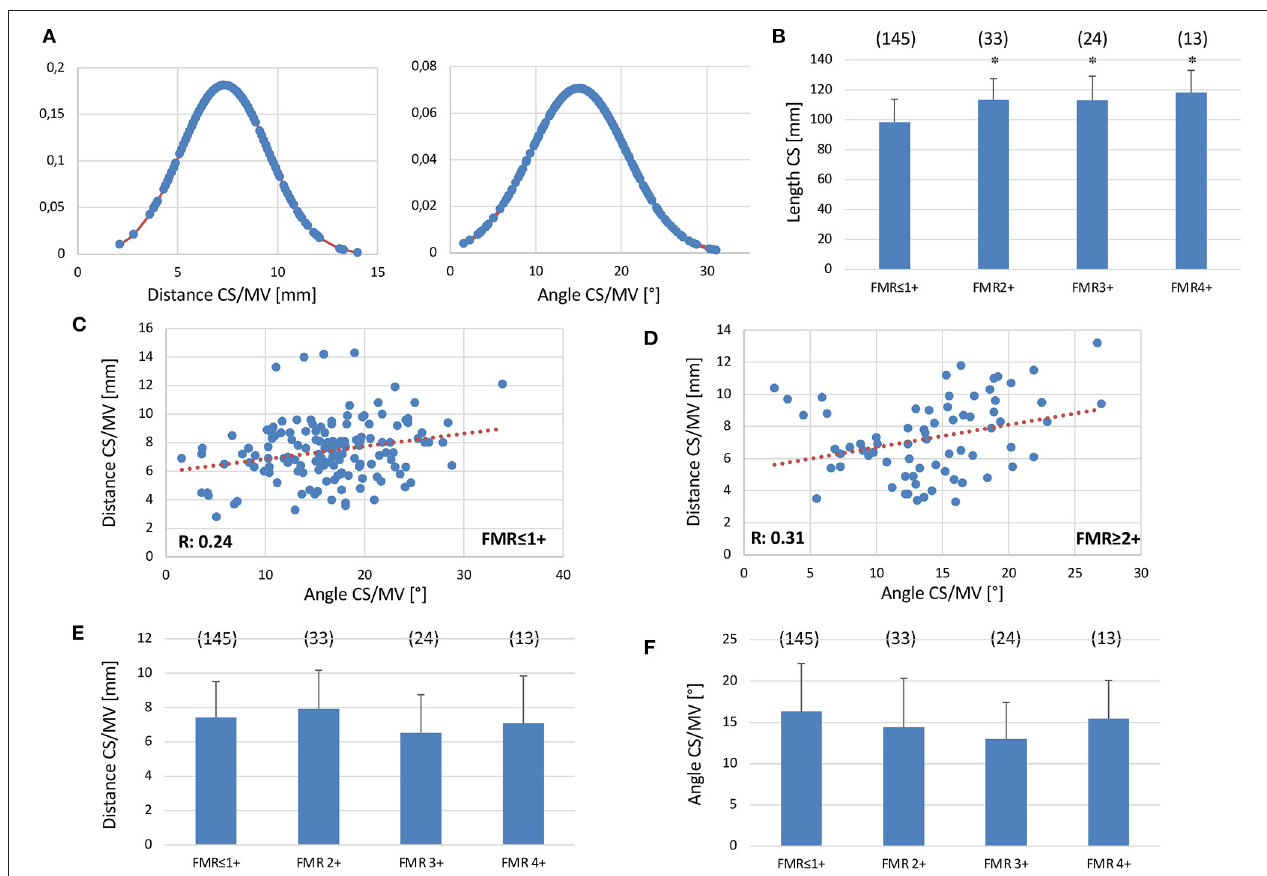
FIGURE 4 | Coronary Sinus to Mitral Valve anatomy and topography in the presence and absence of FMR. (A) Gaussian function showing normal distribution of distance (left) and angulation (right) of CS to MVA planes ( n = 215). (B) Total CS length in patients with FMR ≥ 2 + and FMR ≤ 1 + . Correlation of distance and angulation of CS to MVA planes of patients with FMR ≤ 1 + (C) or FMR ≥ 2 + (D) . (E) No difference between the distance of CS to MVA in patients with FMR ≤ 1 + or with FMR2 + , FMR3 + or FMR4 + . (F) No difference between angulation of CS to MVA in patients with FMR ≤ 1 + or with FMR2 + , FMR3 + or FMR4 + . Mean ± SD. * p < 0.05 vs.